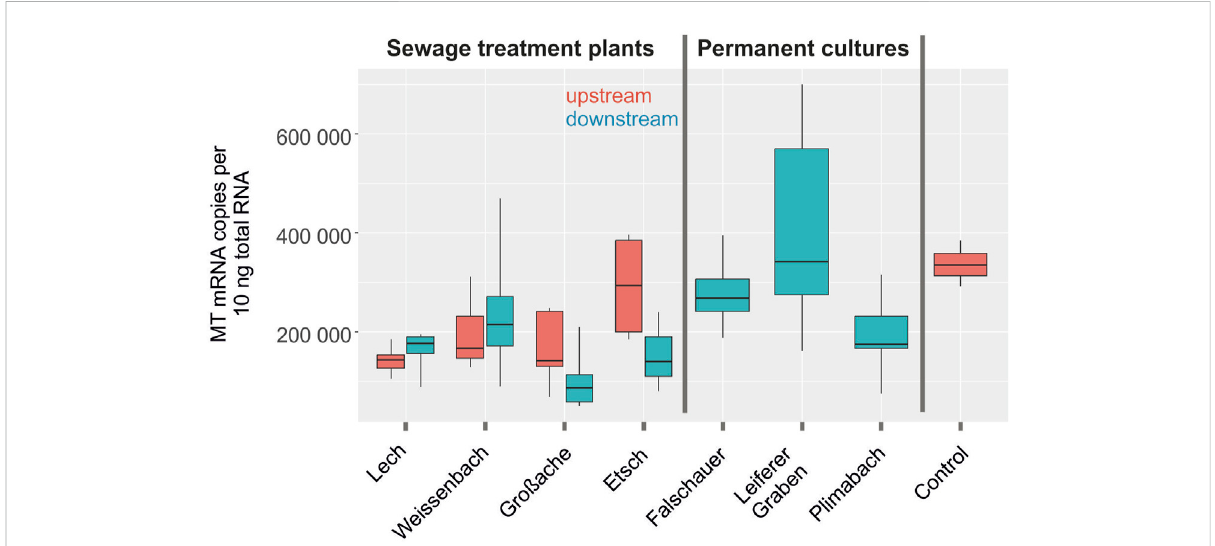
FIGURE 4 Metallothionein expression levels (mRNA copy numbers per 10 ng total RNA) in liver tissues of C. gobio in river streams of control individuals upstreamofasewagetreatmentplant(red)andindividualsdownstreamthesewagetreatmentplant(turquoise)(alllabeledsewagetreatmentplants). Rivers passing vineyards and orchards are labeled permanent